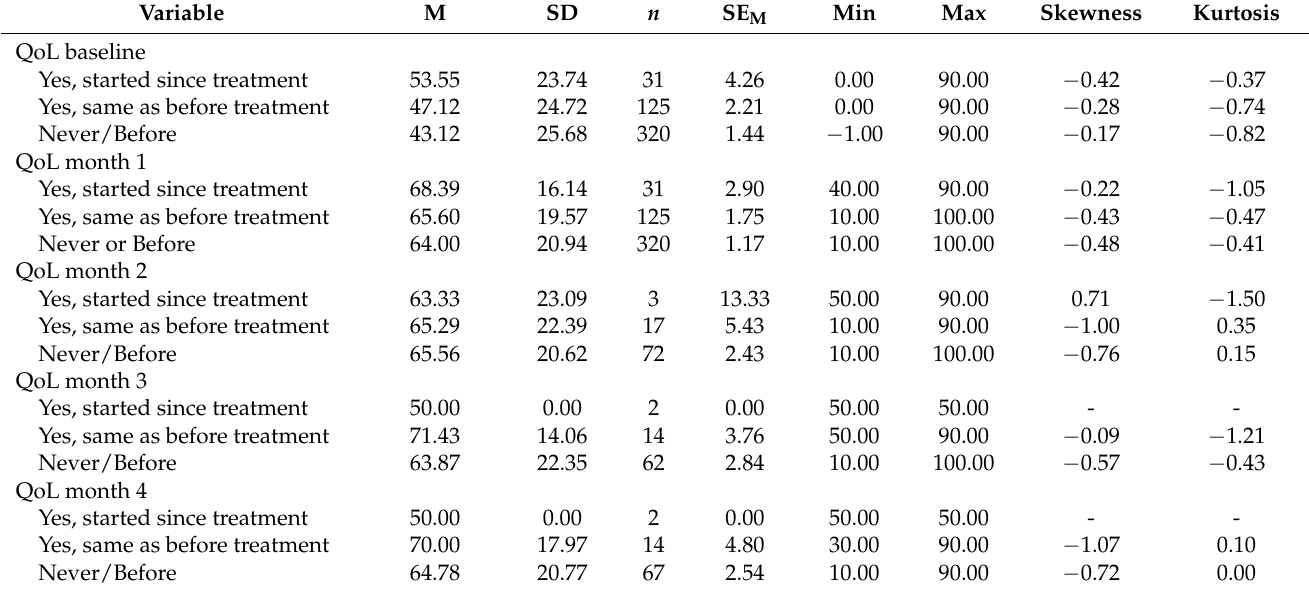
Table 6. Summary statistics of QoL by MS Diet levels.